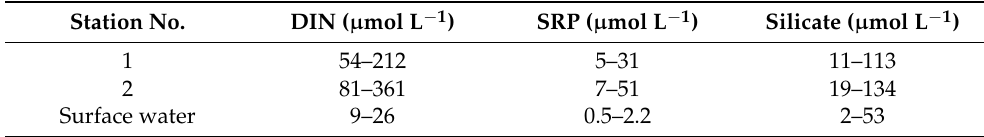
Table 2. Range of nutrient concentrations in pore water (sediments) and surface water of both sampling stations no. 1 and 2 during the course of one year between October 2009 and October 2010 (three samplings: October, April, and July; n = 3, respectively). Chemical parameters of the pore water are based on sediment slices to a 3-cm sediment depth. DIN: dissolved inorganic nitrogen; SRP: soluble reactive phosphorus; all concentrations are given in µ mol L − 1